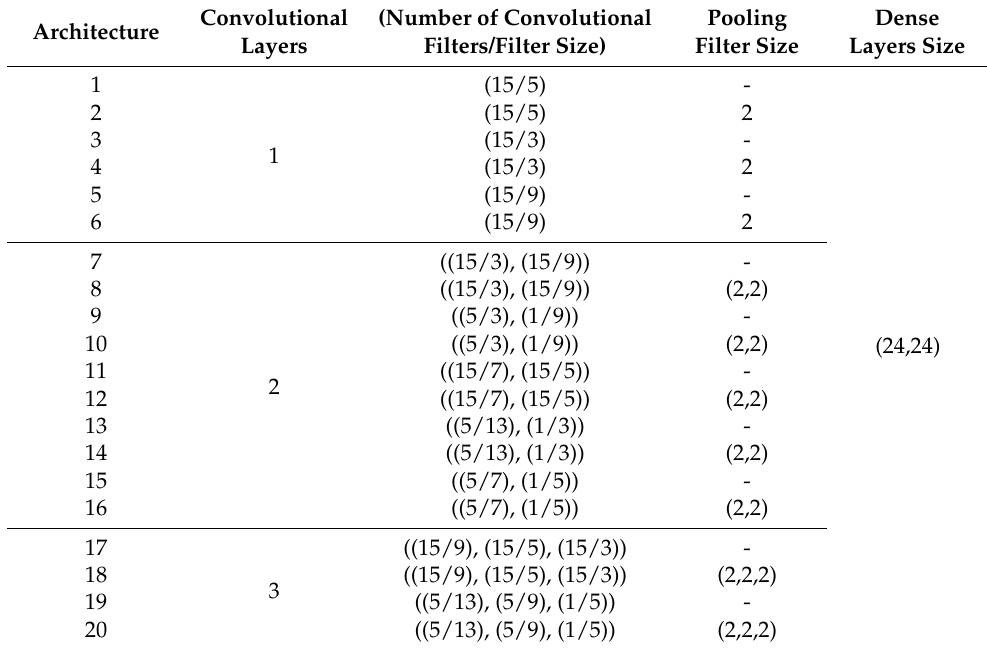
Pooling Filter Size